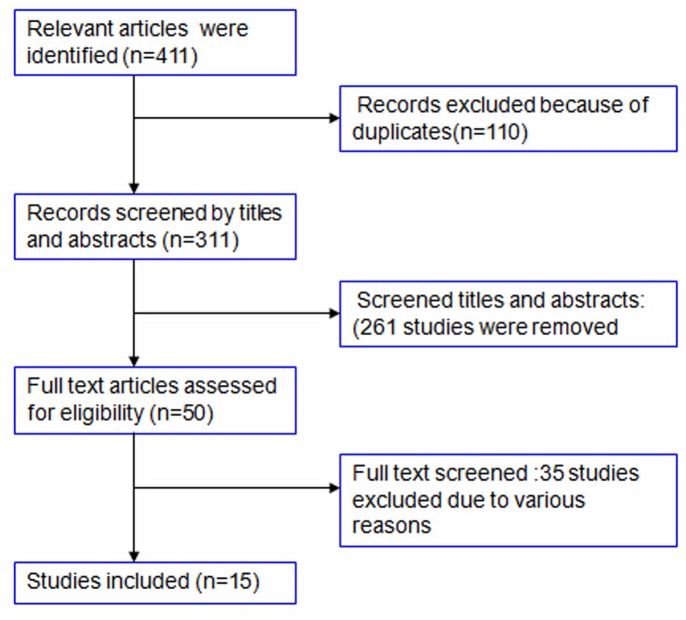
Flow chart of study selection.